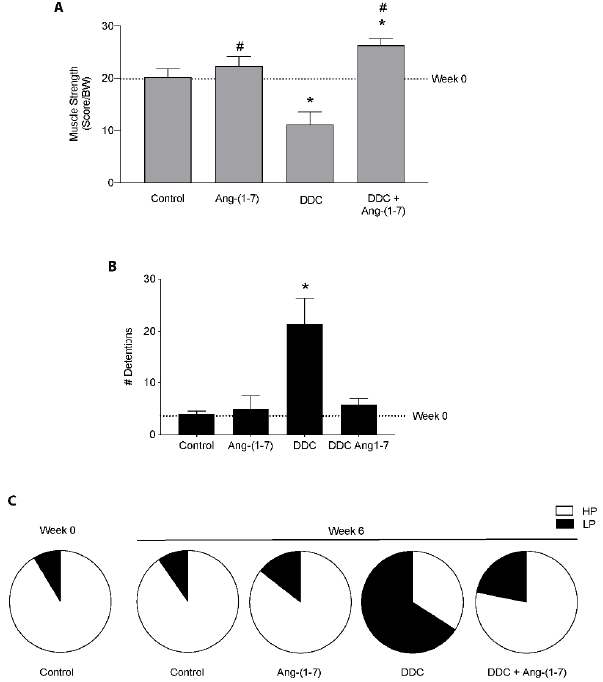
Figure 1. Ang-(1-7) prevents the decrease of muscle function in mice fed with the DDC diet. Male mice C57BL/6J (16 weeks old) were randomly separated into four groups defined as Control, Ang-(1- 7), DDC, and DDC + Ang-(1-7). Ang-(1-7) was administered through osmotic pumps. The mice were fed for six weeks with a standard diet or with a DDC-supplemented diet. ( A ) At week 0 and week 6, mice were assessed for muscle strength measured by weightlifting test. Values represent a score which is normalized per body weight. ( B ) Running test results was expressed as the number of detentions in the treadmill. ( C ) Performance in the running test was determined as the time spent in the Low-Performance zone (LP) and High-Performance zone (HP). Values in A, B, and C are shown as mean ± SEM. Five or six animals per group were used for three independent experiments (* p < 0.05 vs. Control, # p < 0.05 vs. DDC. Two-way ANOVA, Tukey’s multiple comparisons test).